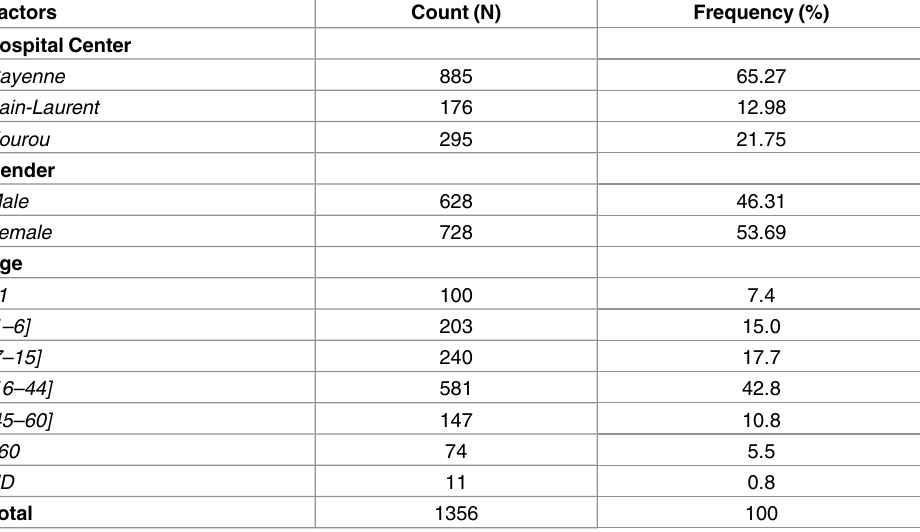
Table 1. Distribution of hospital centersand sociodemographic variables among hospitalized cases (n = 1356), French Guiana,